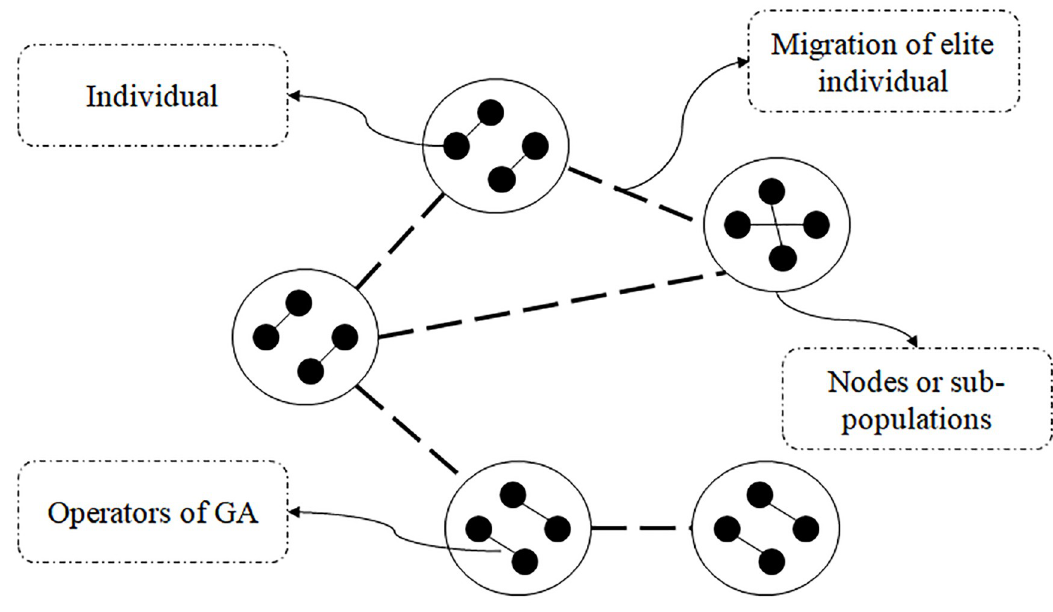
Fig 1. Schematic diagram of